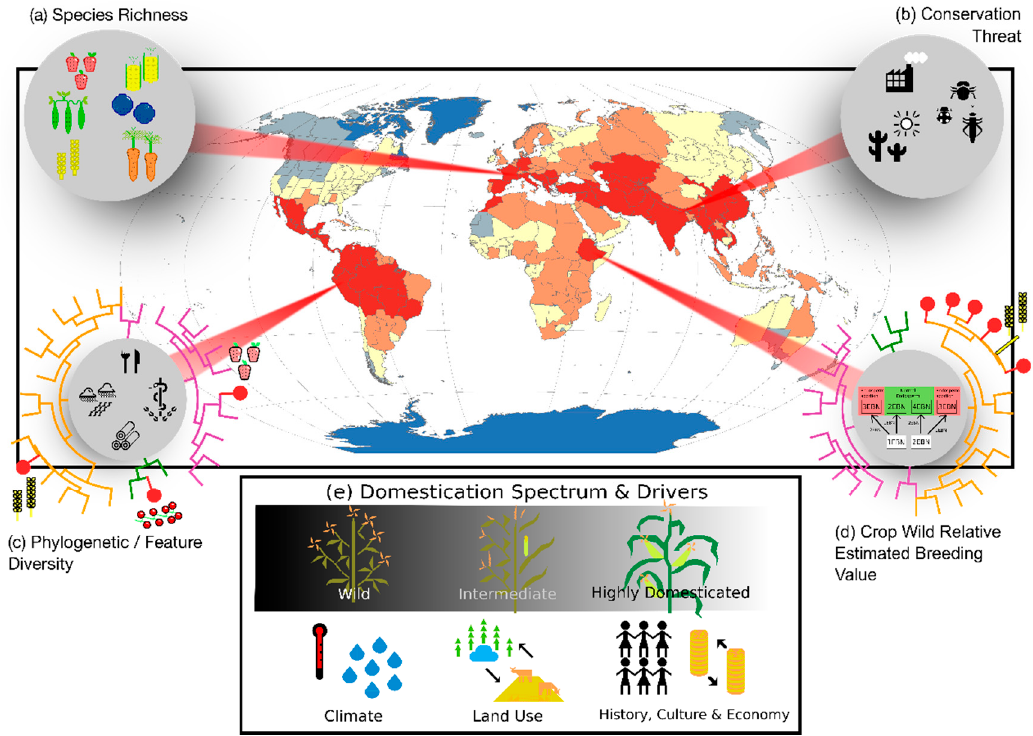
Figure 5. The conceptual framework for the identification of agro-biodiversity hotspots, including ( a ) plant species richness (applicable to infra-specific levels as well); ( b ) threats; ( c ) species (or infra-specific taxa) evolutionary and features diversity; ( d ) crop wild relatives estimated breeding value; and accounting for ( e ) the geographic continuum between hotspots of wild species diversity and regions containing high concentrations in major crops (i.e., highly domesticated species), and its environmental and human drivers. The map does not provide a new estimate of the distribution of agro-biodiversity hotspots, but rather illustrates a combination of the potential two ends of the domestication spectrum: Major crop species richness (Figure 3a) and species richness undocumented in Wikipedia (Figure 2c). High to low species richness is represented from red to blue.